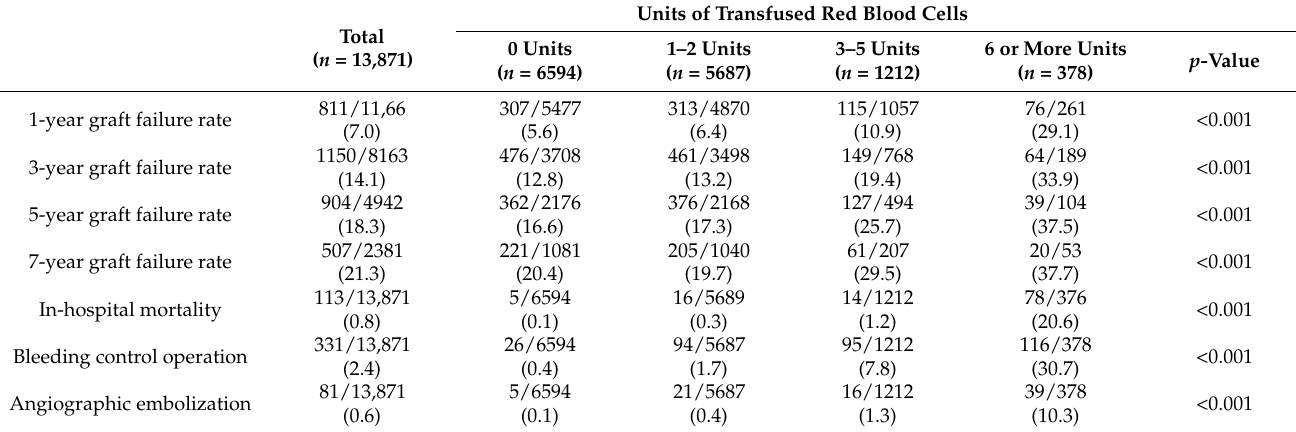
Table 2. Graft failure rate, in-hospital mortality, and perioperative bleeding events according to the amount of transfusion. Total ( n = 13,871)